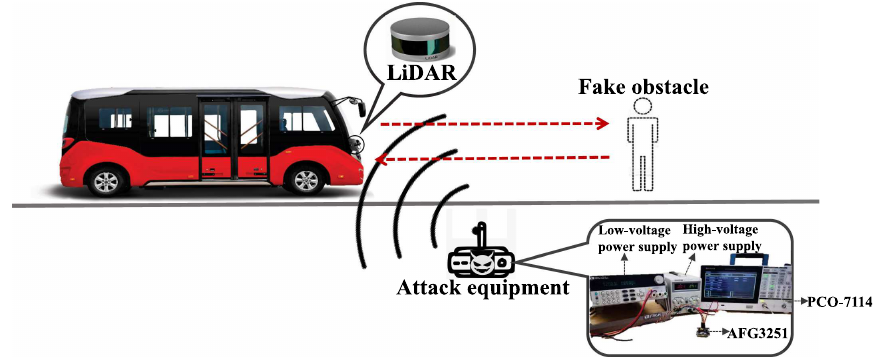
Figure 8. Adversarial sensor attack on LiDAR-based perception